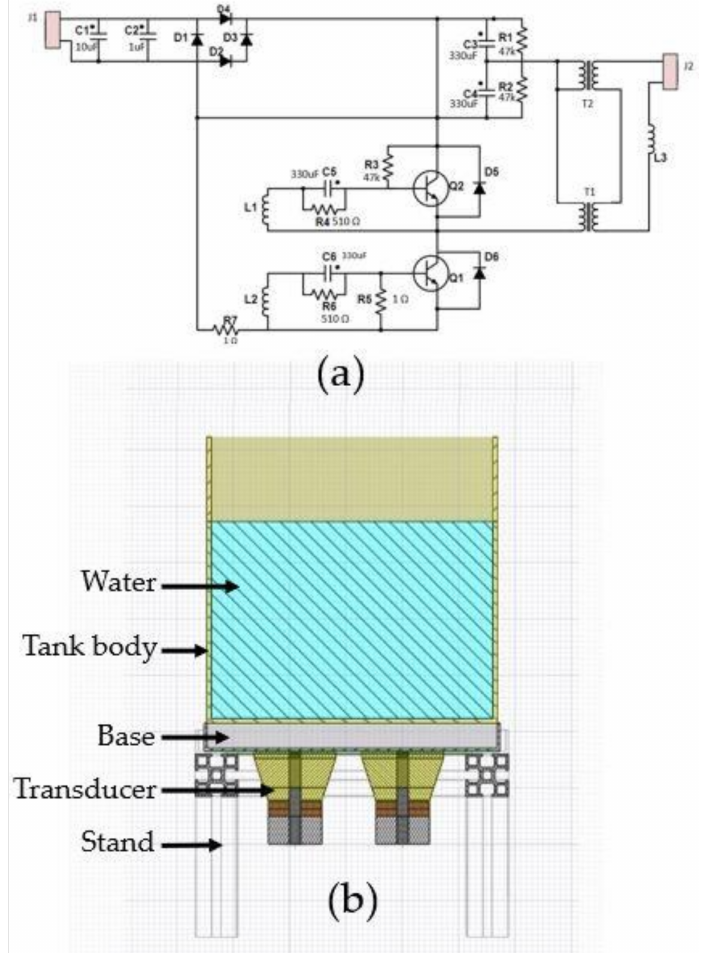
Figure 4. Diagrams of ( a ) an electric circuit and ( b ) a CAD model of